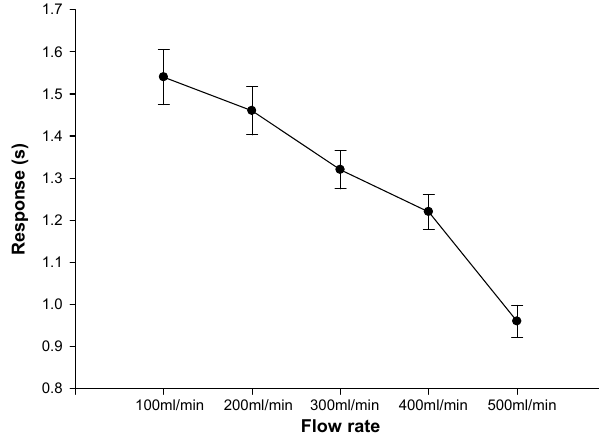
Figure 13. Test results of blood flow and blood leakage detection.